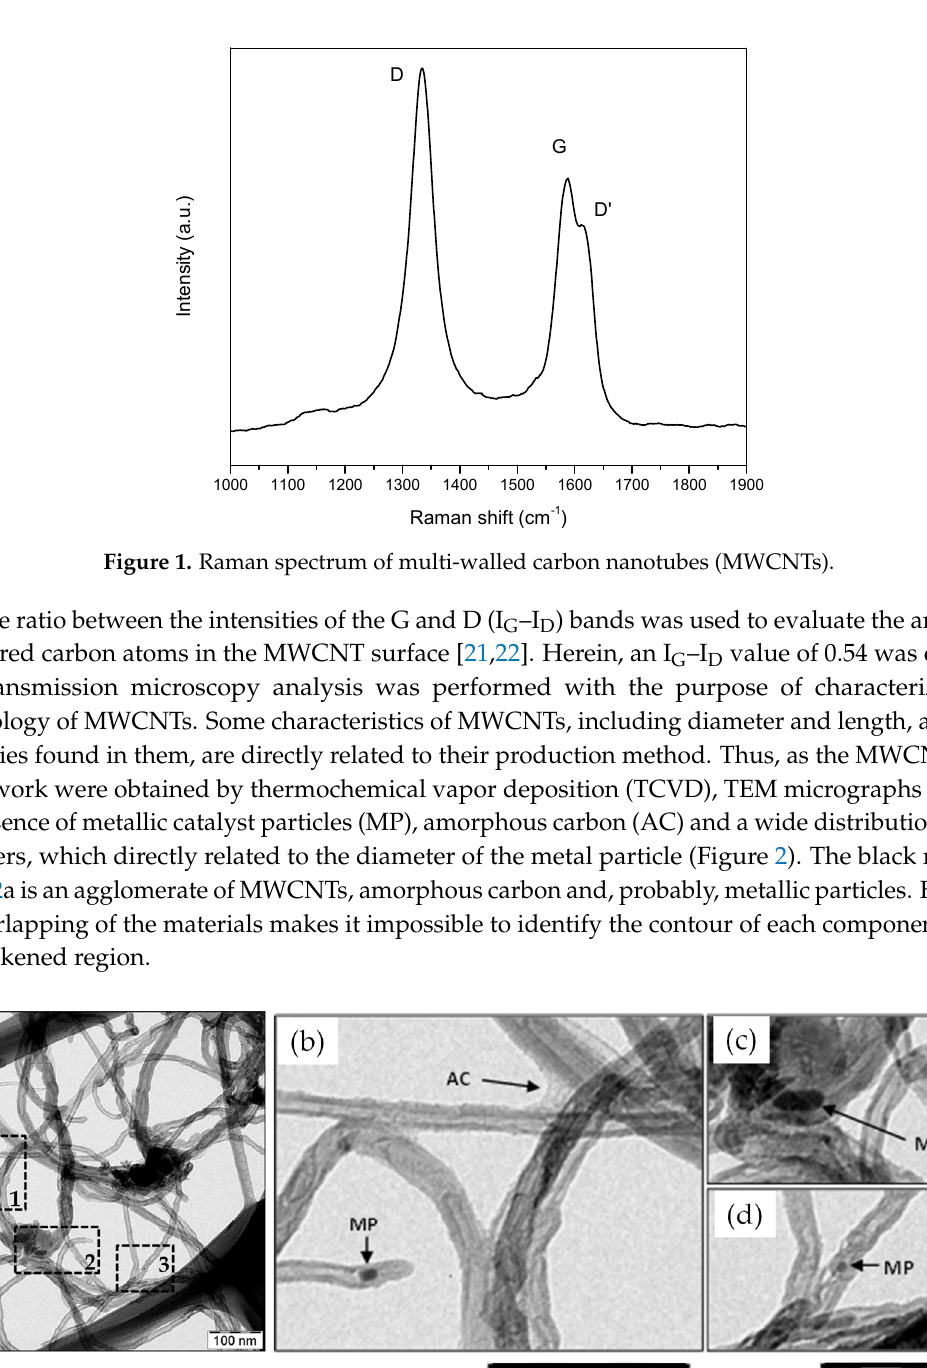
Figure 2. ( a ) TEM image of MWCNTs; ( b ) magnification region 1; ( c ) magnification region 2; ( d ) magnification region 3. MP: metallic catalyst particles; AC: amorphous carbon.